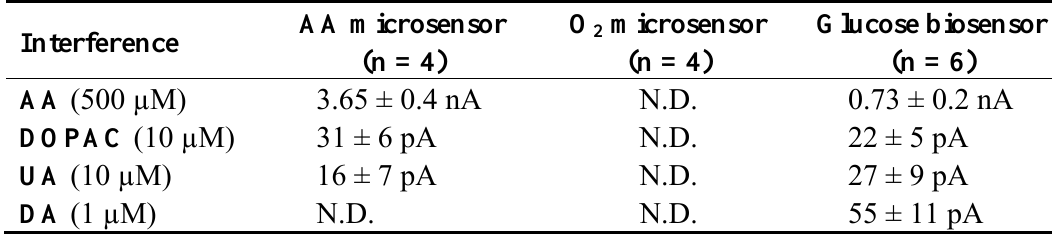
Table 1. Effects of some electroactive molecules (AA, DOPAC, UA and DA) present in the striatal ECF on the amperometric response of the AA, O (response) not